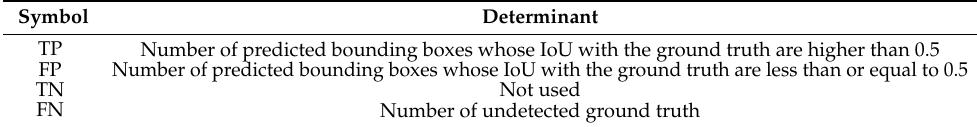
Table 2. Definitions of